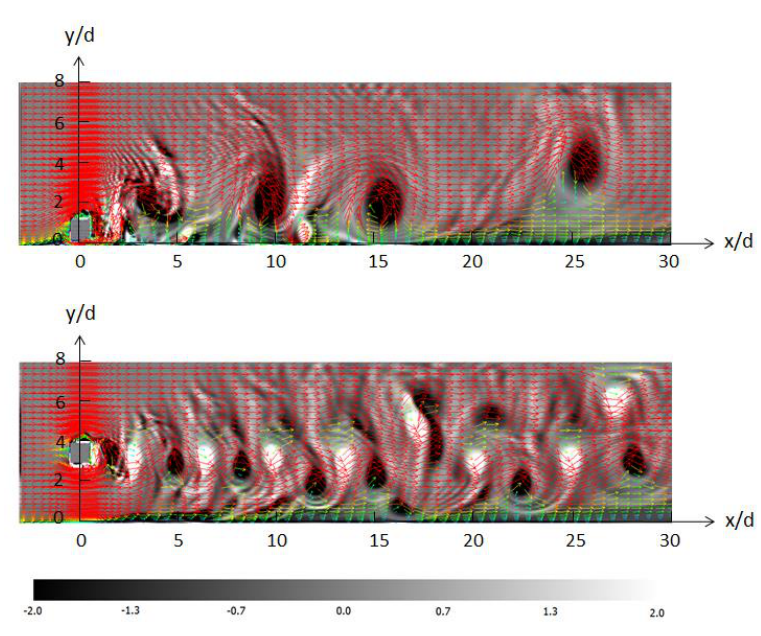
Fig. 2 Normalized instantaneous spanwise vorticity (black and dark gray: negative/clockwise; white and light gray: positive/counter-clockwise) and velocity vector (red: high-speed; blue: low-speed). Upper image: 25.0/  dC ; lower